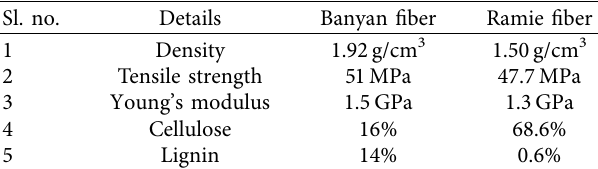
Table 1: General properties of banyan and ramie fibers. Sl.